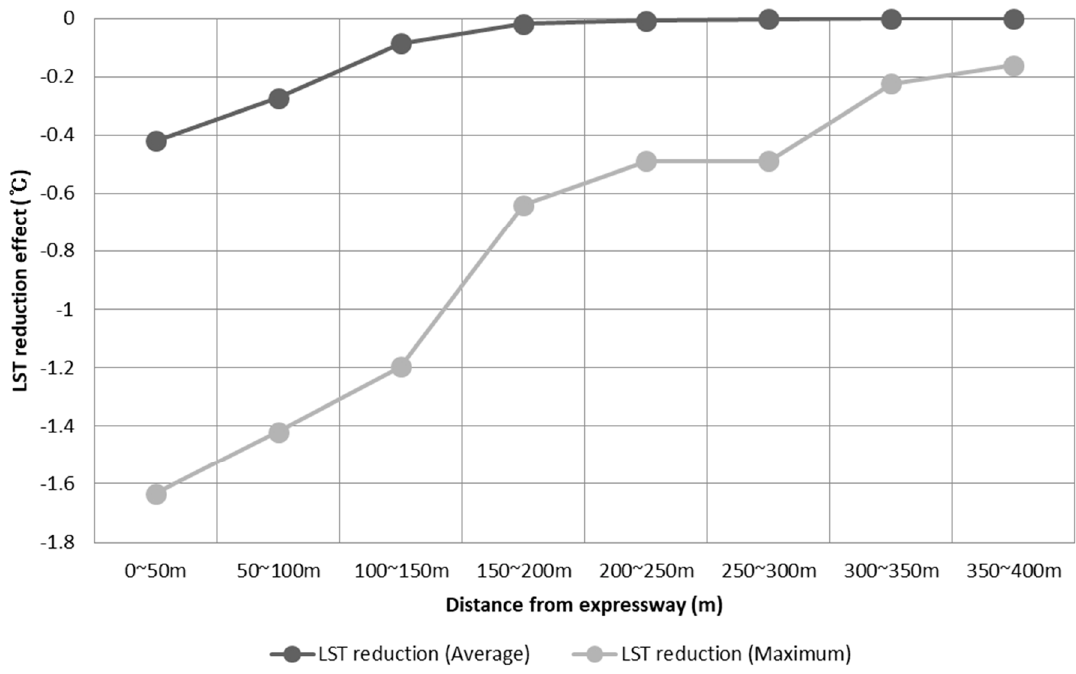
Figure 9. Average and maximum LST reduction after greening project (50 m~500 m).